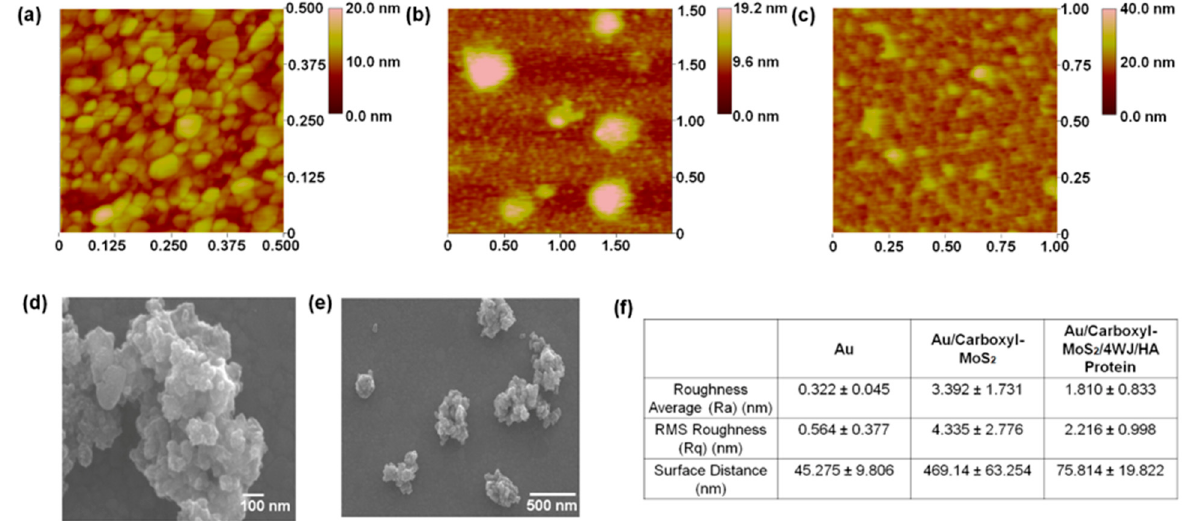
Figure 3. ( a ) surface morphology of bare Au substrate by AFM, ( b ) Surface morphology of carboxyl-MoS 2 self-assembled Au electrode by AFM, ( c ) Surface morphology of HA protein/DNA 4WJ on carboxyl-MoS 2 self-assembled Au electrode by AFM. ( d ) Particle analysis of carboxyl-MoS 2 by FE-SEM, (100 nm scale), ( e ) Particle analysis of carboxyl-MoS 2 by FE-SEM, (500 nm scale) ( f ) Surface roughness and surface distance analysis of fabricated biofilm.